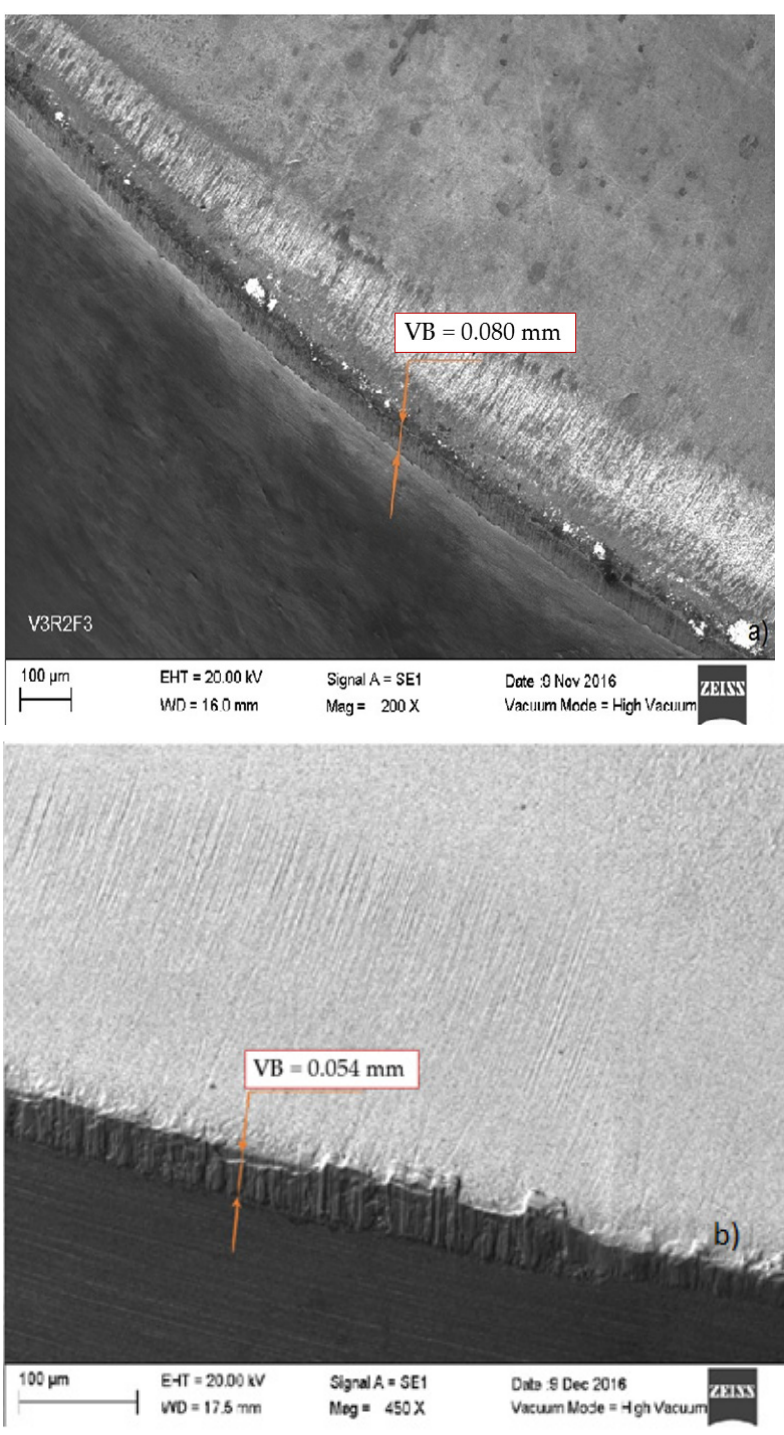
Figure 8. Wear on the incidence surface of the cutting tool for V = 400 m/min and f = 0.1 mm/r: ( a ) dry and ( b ) with MQL.